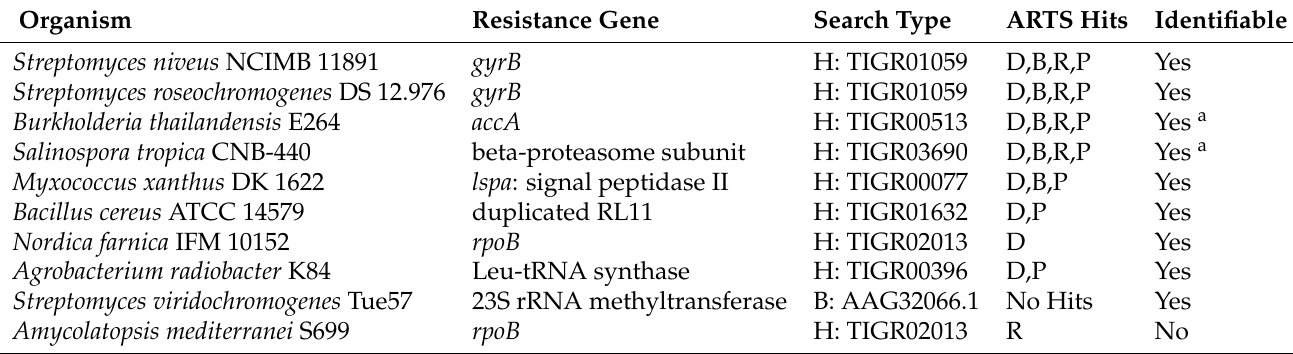
Table 1. SYN-view analysis of example antibiotic producing strains with identified self-resistance genes. For comparison, respective ARTS hits are also provided from previous papers [11,21] (D: Duplication, B: BGC proximity, R: Resistance, P: Phylogeny). “Search Type” column indicates how the search was performed: H stands for HMM mode while B stands for blastp and the following indicates the corresponding TIGRFAM model and gene accession number, respectively. Easily identifiable differences are denoted as “Yes”, if no difference is visible marked as